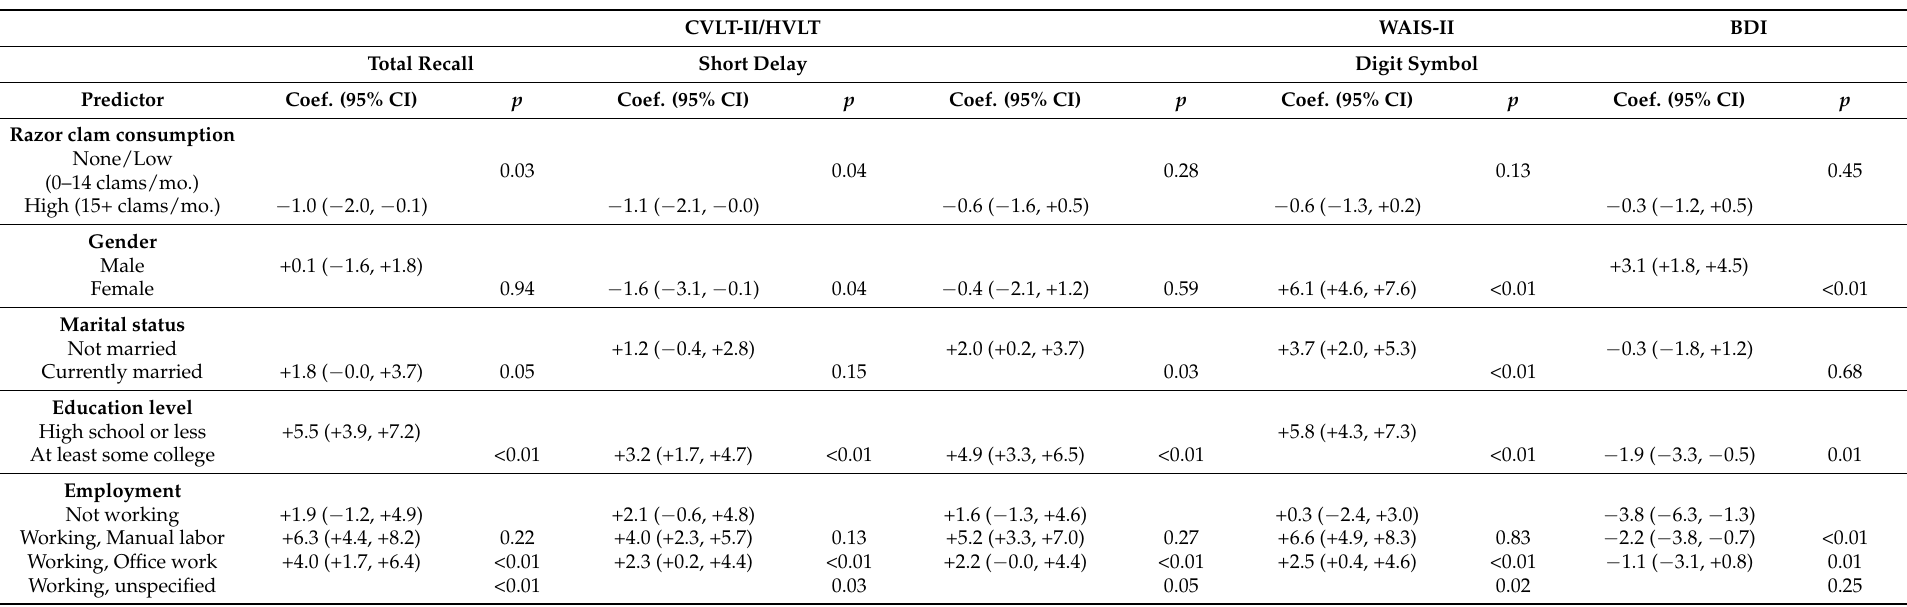
Table 3. Year-adjusted relative expected cognitive scores, by baseline characteristics, over